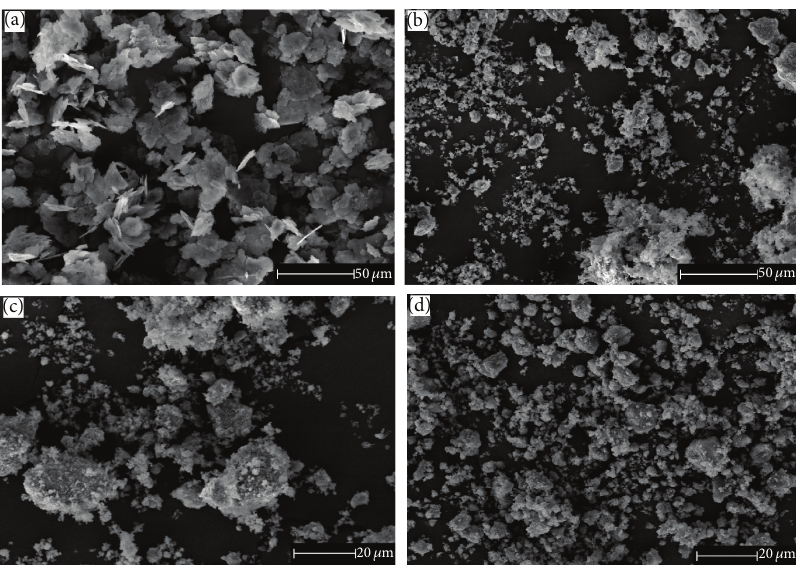
Figure 3: Morphologic evolution of powder milled in NH 3 flow at 500 rpm for (a) 1h, (b) 2 h, (c) 3 h, and (d) 5 h. Note the different magnification used.